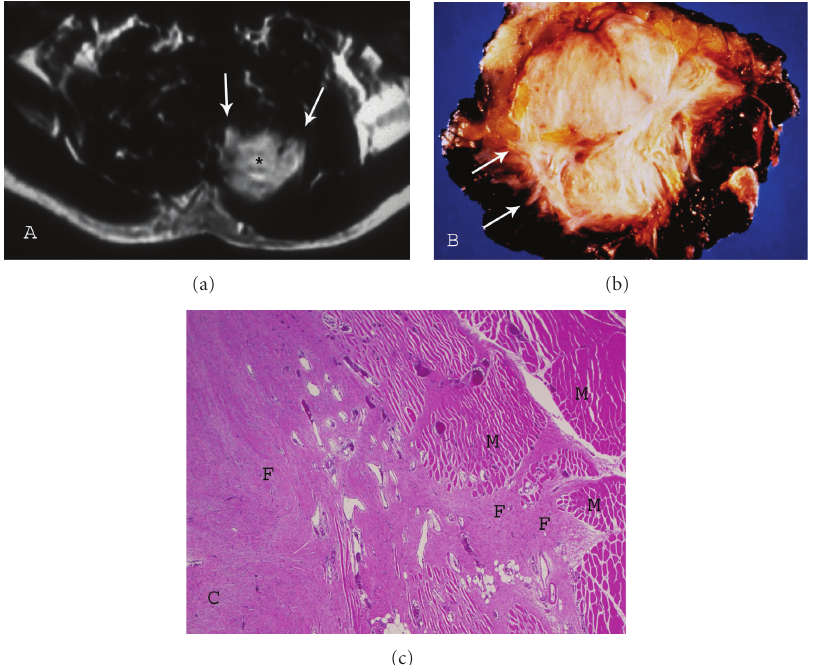
Figure 8: Paraspinal fibromatosis with infiltrative borders. (a) Axial postcontrast T1-weighted (TR500/TE20) sequence demonstrates fibromatosis of the paraspinal muscles with prominent enhancement (asterisk) and infiltrative margin (arrows). (b) Photograph of gross specimen reveals multiple collagenized bands and irregular, spiculated margin (arrows). (c) Photomicrograph (original magnification, × 100; H-E stain) also illustrates the marginal invasion of muscle (M) by the collagenized fibromatosis lesion